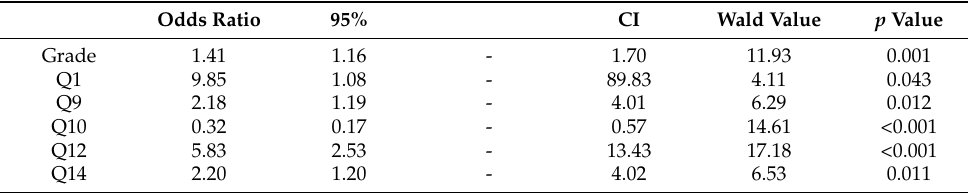
Table 5. Factors associated with willingness to receive a third dose of the COVID-19 vaccine among medical